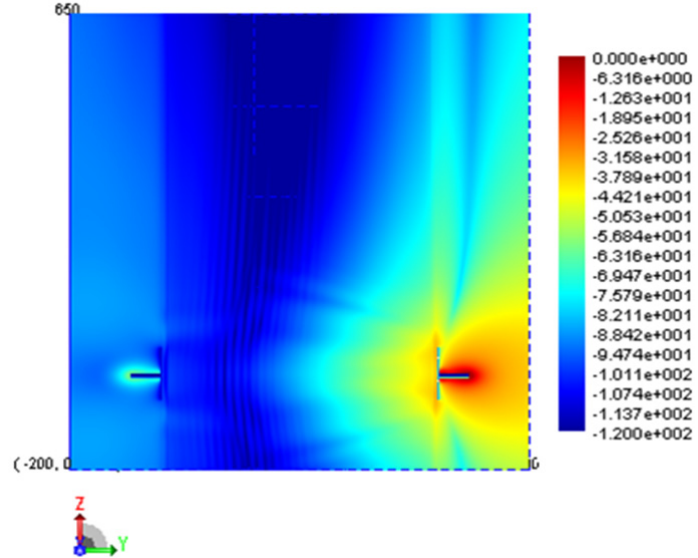
Figure 6. Electric field distribution on a vertical cut plane bisecting the cylindrical